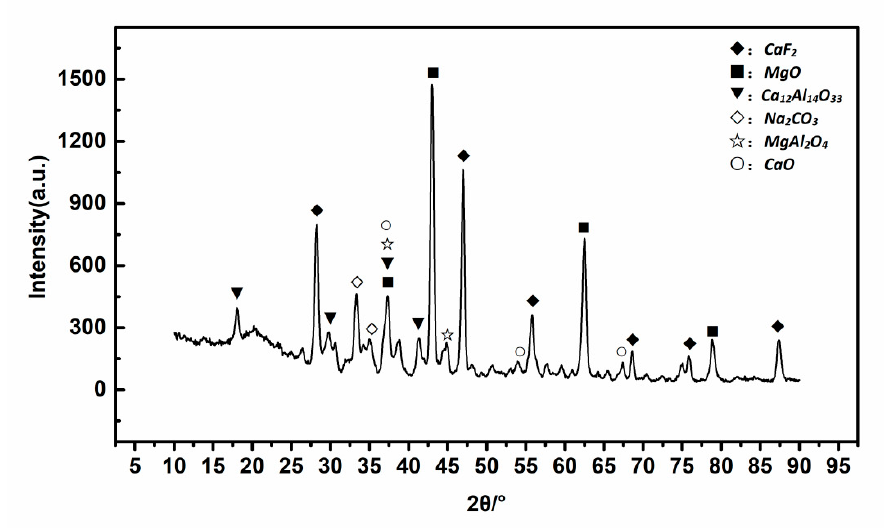
Figure 4. XRD pattern of the final product.